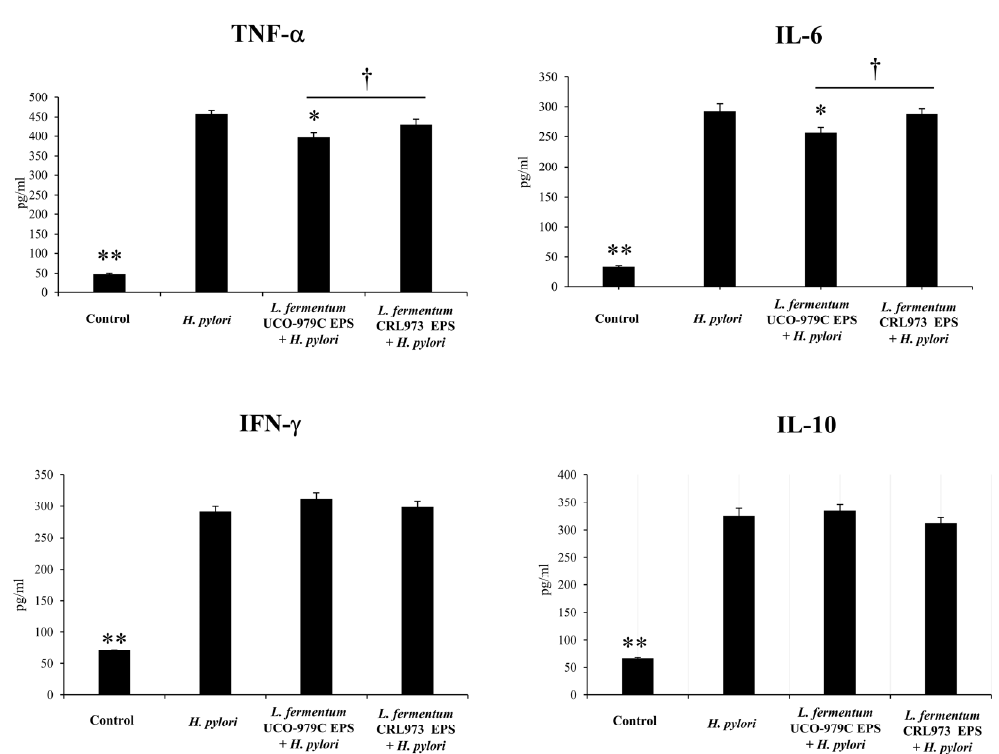
Figure 9. E ff ect of Lactobacillus fermentum UCO-979C or L. fermentum CRL973 EPS on cytokine and chemokine production of human macrophages (THP-1 cells) after Helicobacter pylori challenge. THP-1 cells were incubated with 100 µ g / mL of L. fermentum UCO-979C or L. fermentum CRL973 EPS for 24 h. Then, cells were challenged with H. pylori 43504. The levels of TNF- α , IL-6, IFN- γ and IL-10 (pg / mL) in culture supernatants were determined 24 h after infection. The results represent data from three independent experiments. Results are expressed as mean ± standard deviation. Significant di ff erences when compared to the control group: * ( p < 0.05), ** ( p < 0.01). Significant di ff erences when compared to the indicated group: † ( p < 0.05).